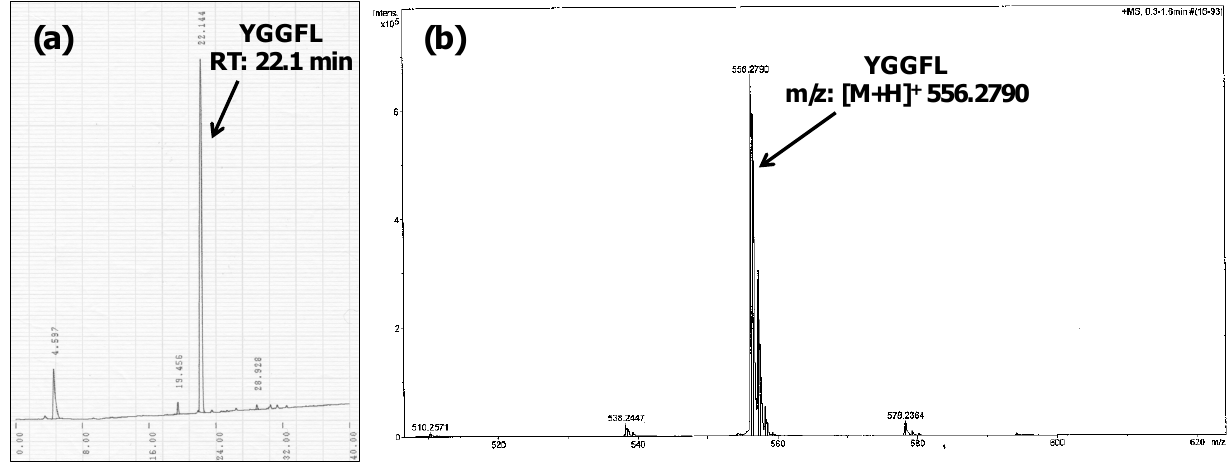
Figure 3. ( a ) Analytical HPLC profile; and ( b ) mass spectra of Leu-enkephalin (YGGFL) obtained by MW assisted solid phase synthesis in water using nanoparticles. Elution was carried out for over 40 min at a flow rate of 1 mL/min with a linear gradient from 9:1 to 5:5 mixture of 0.05% aqueous trifluoroacetic acid (TFA) and 0.05% TFA in acetonitrile. Column: 5C18-Ar-II (2.4 × 250 mm).